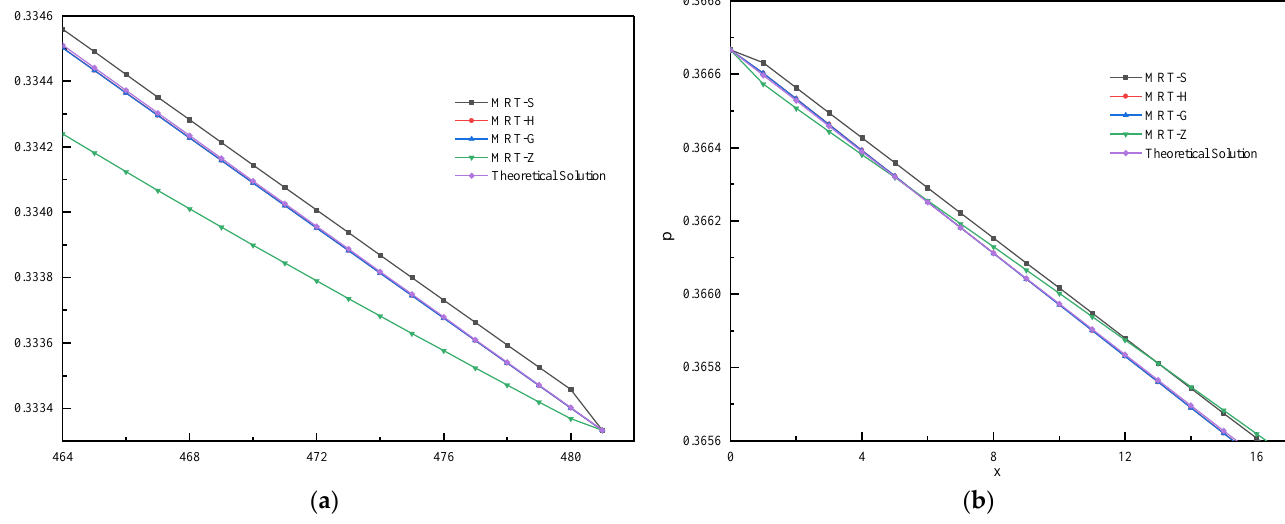
Figure 4. ( a )The profiles of pressure at inlet boundary; ( b ) The profiles of pressure at outlet boundary. To further study numerical accuracy of models, the relative error (RE) and mean absolute relative error (MARE) of velocity are defined